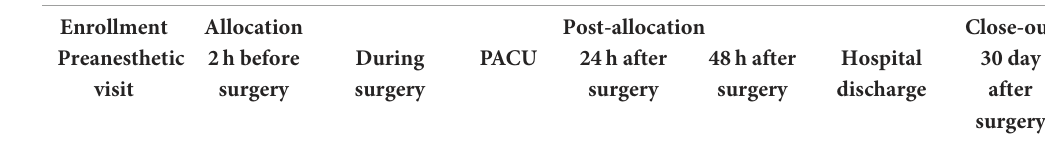
Enrollment Allocation Post-allocation Close-out Preanesthetic 2h before During PACU 24h after 48h after Hospital 30 day visit surgery surgery surgery surgery discharge after